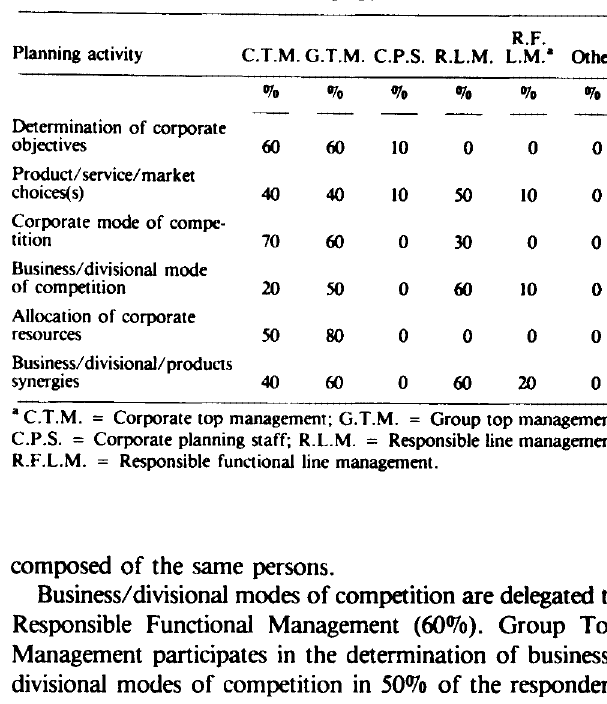
Table Sa Broad distribution of planning